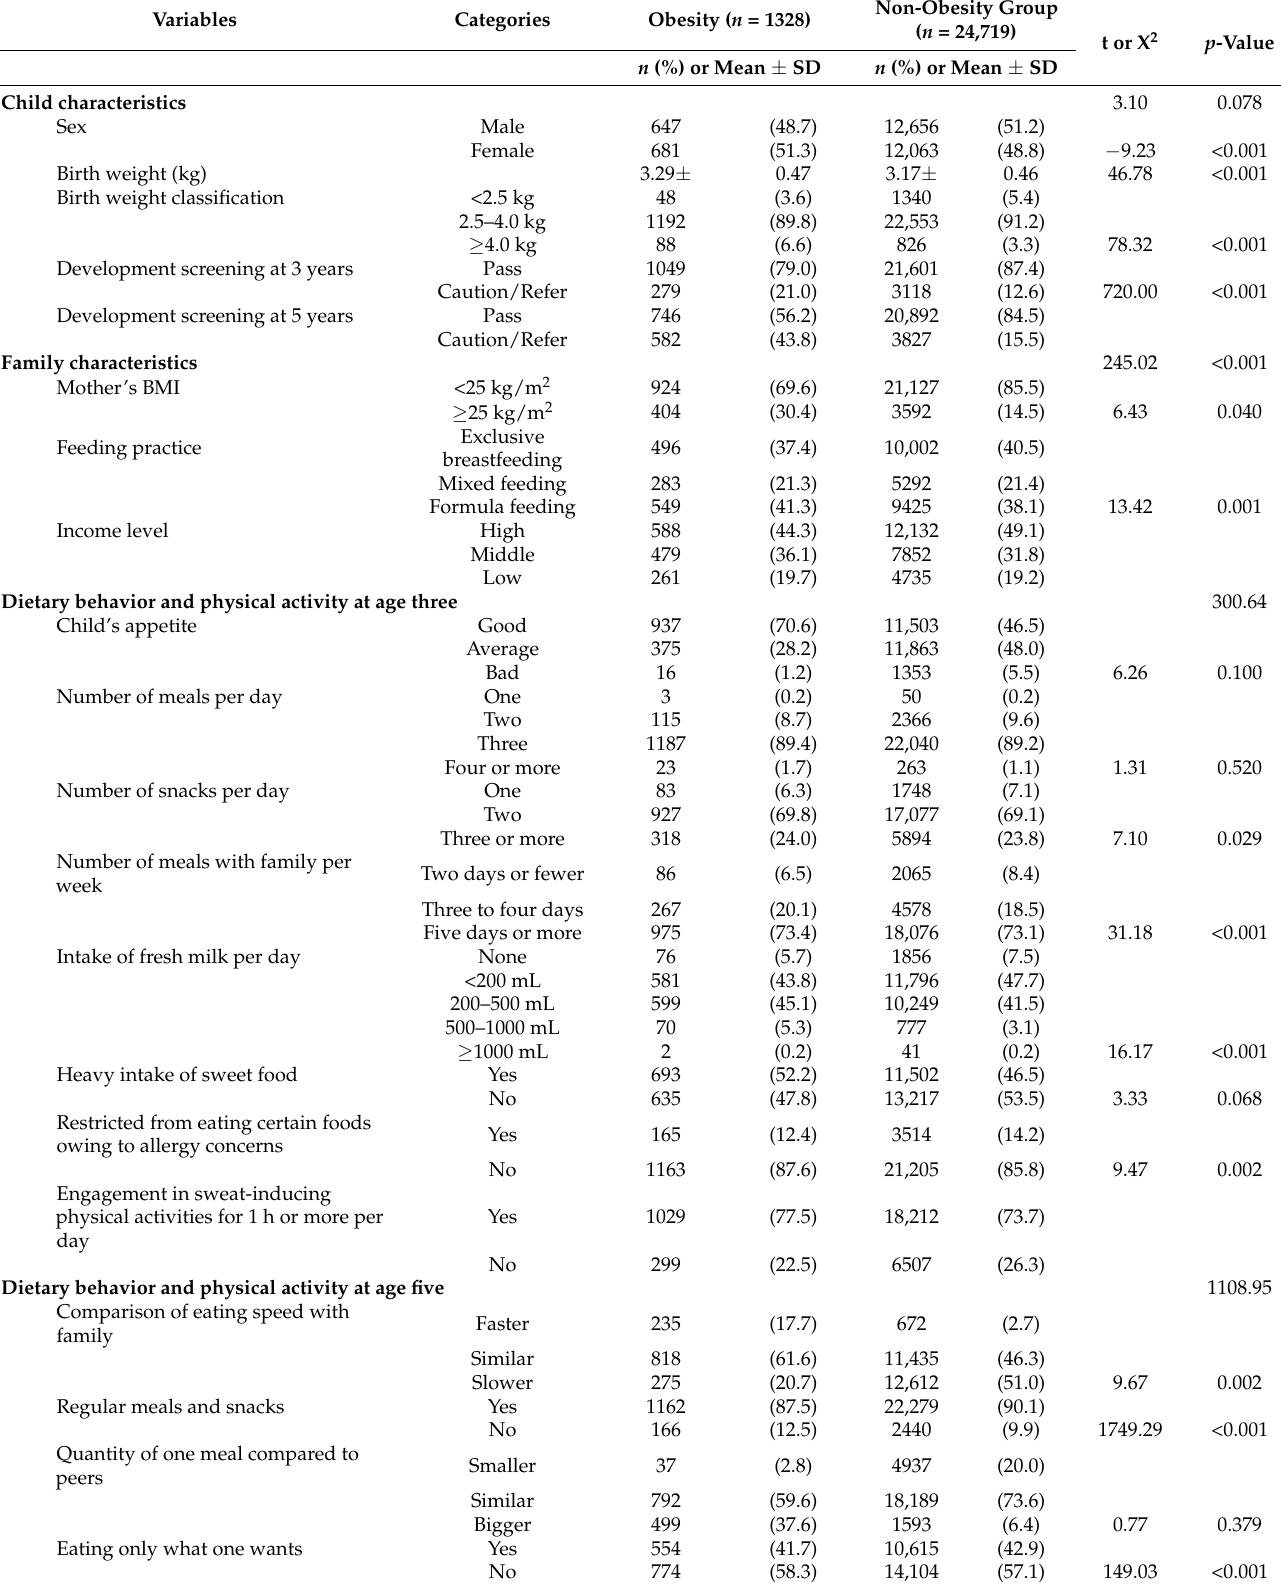
Table 2. Differences between obesity and non-obesity groups according to the main variables ( n =